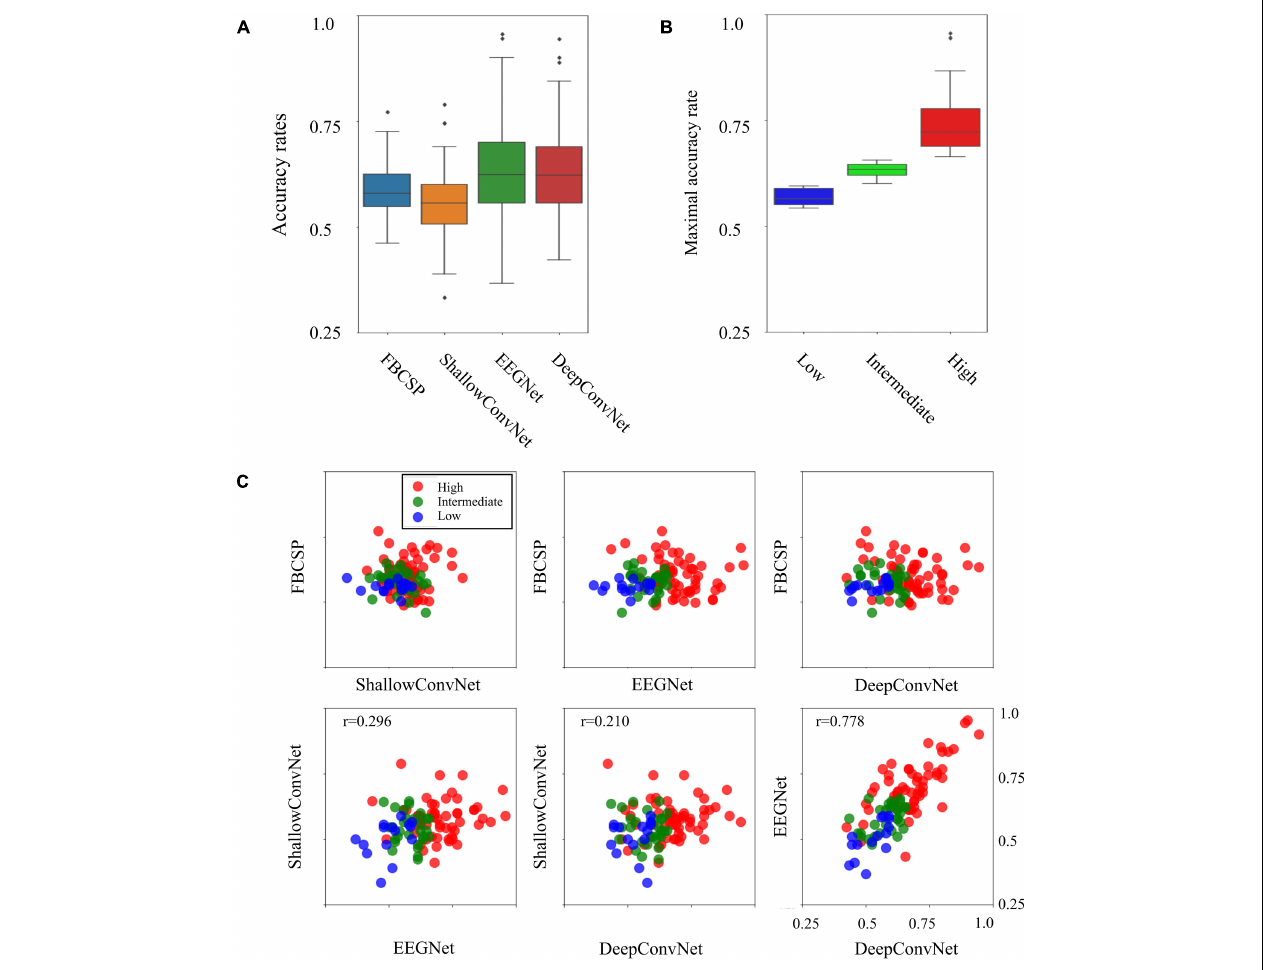
FIGURE 1 | Four decoding results and three BCI groups. (A) Comparison of accuracy rates between four different decoding methods. (B) Boxplots indicating BCI performance as the maximum accuracy rates across four decoding methods in the three BCI groups. (C) Scatterplots of binary classification accuracy rates for all possible pairwise comparisons between two decoding methods. The tick labels of the x - and y -axes in all the plots are the same as tick labels presented in the right bottom